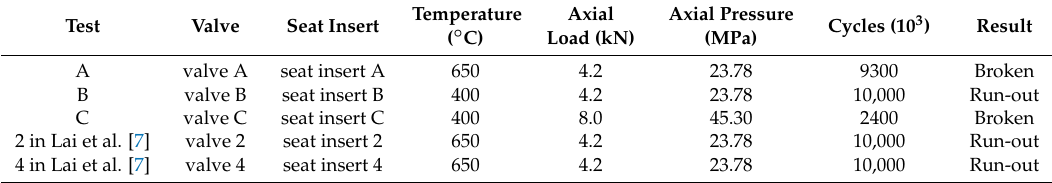
Table 7. Durability test conditions and results.